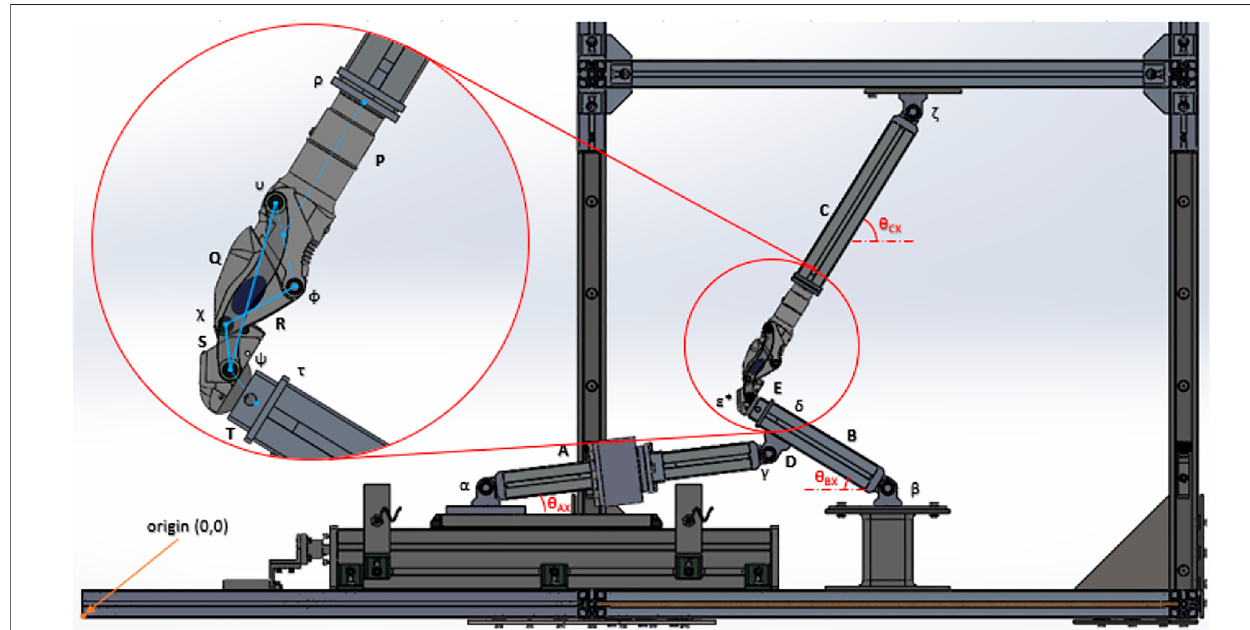
FIGURE 5 | Diagram of the Cartesian method of the Geometry Model for the Ottobock 3R106 (Dobner).